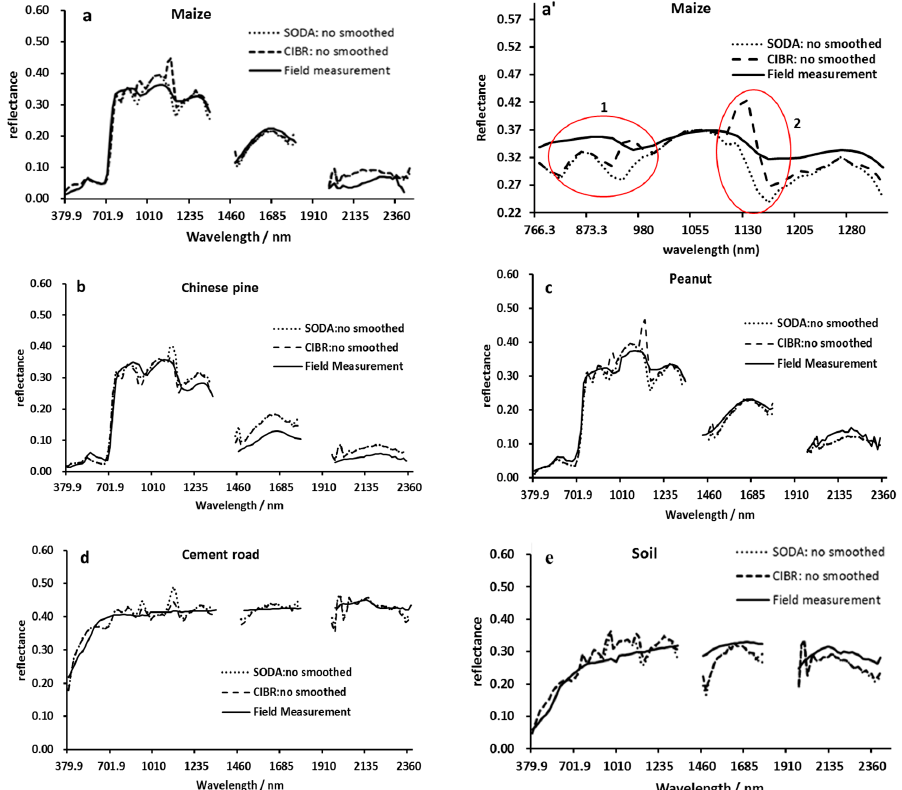
Figure 9. Comparison of the surface reflectance from retrieved airborne images with the at-ground reflectance. ( a ) Maize, ( b ) Chinese pine, ( c ) Peanut, ( d ) Cement road, and ( e ) Soil. Symbol SODA is the second-order difference algorithm to retrieve columnar water vapor and CIBR is Continuum Interpolated Band Ratio algorithm to retrieve columnar water vapor. Symbol “no smoothed” is that the surface reflectance spectra are calculated using Equations (4) and (5) without smoothing techniques. To highlight the differences between the CIBR and SODA methods, surface reflectance of maize within 766–1340 nm are scaled in panel ( a’ ).